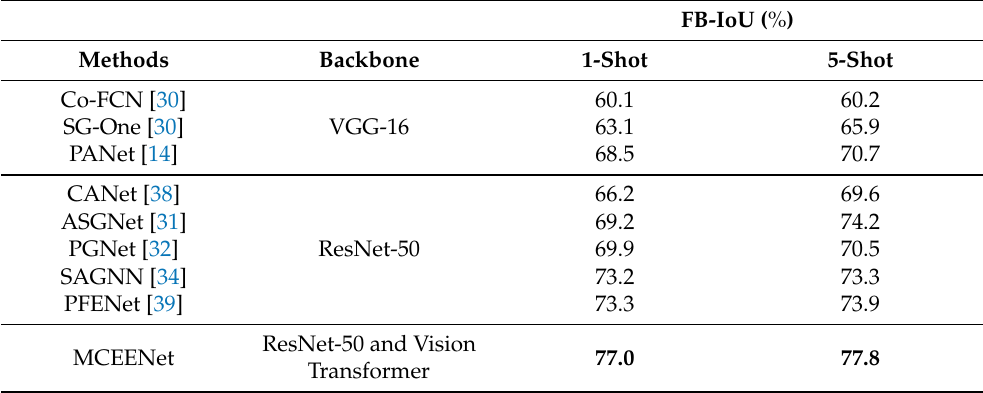
Table 4. Results of MCEENet and other state-of-the-art FSS methods on four folds of the PASCAL-5 i dataset in terms of FB-IoU. The highest performance in each column is highlighted in